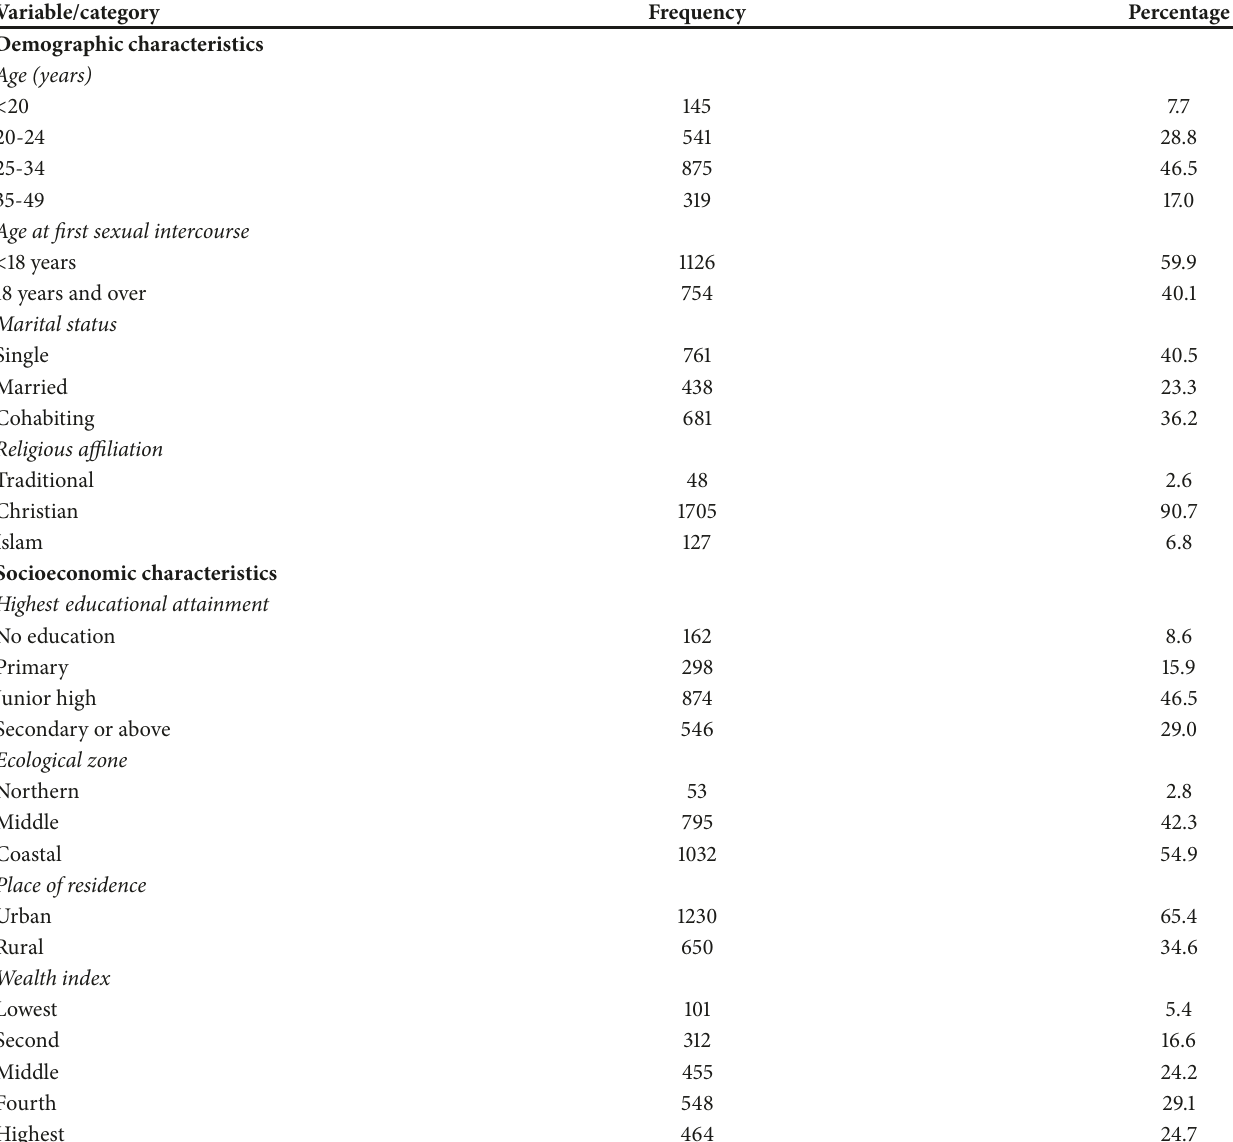
Table 1: Background characteristics of respondents who induced abortion recently (N=1880 unless